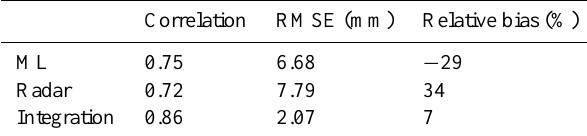
Table 3. Performance analysis event (3) – Dorot